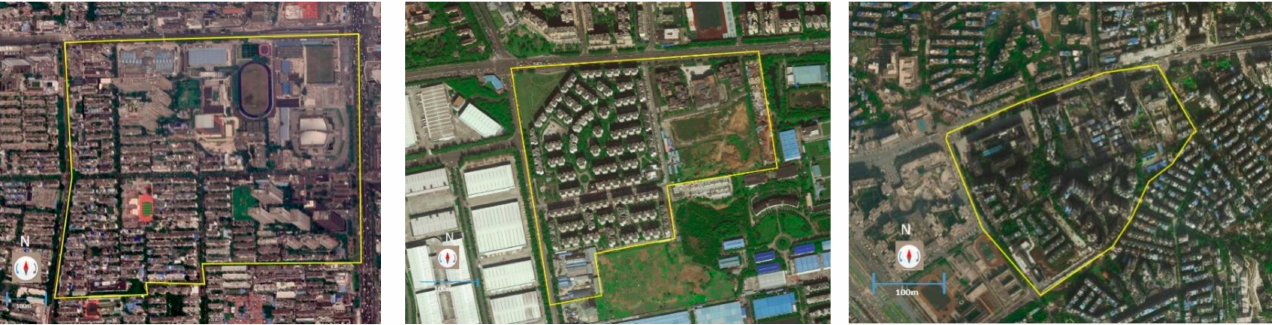
Figure 3. Satellite maps (the same scale) of Yulin, Xingyue, and Jinyang (from left to right) in 2018 (Source: Google